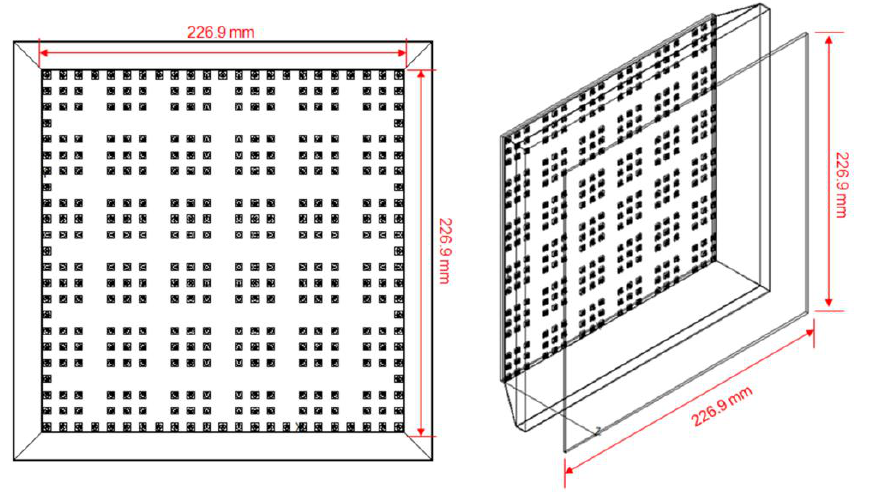
Figure 15. Model of type C.